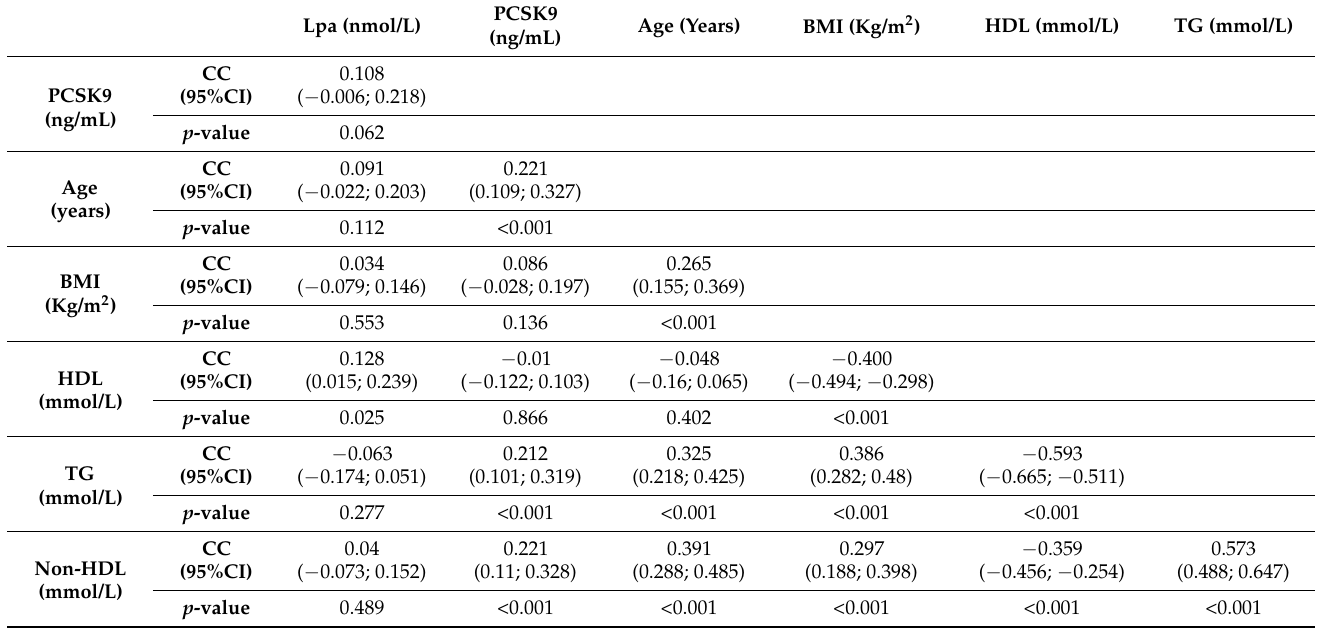
Table 3. Correlation matrix of PCSK9 (ng/mL), age (years), BMI (Kg/m 2 ), HDL (mmol/L), TG (mmol/L), and non-HDL cholesterol